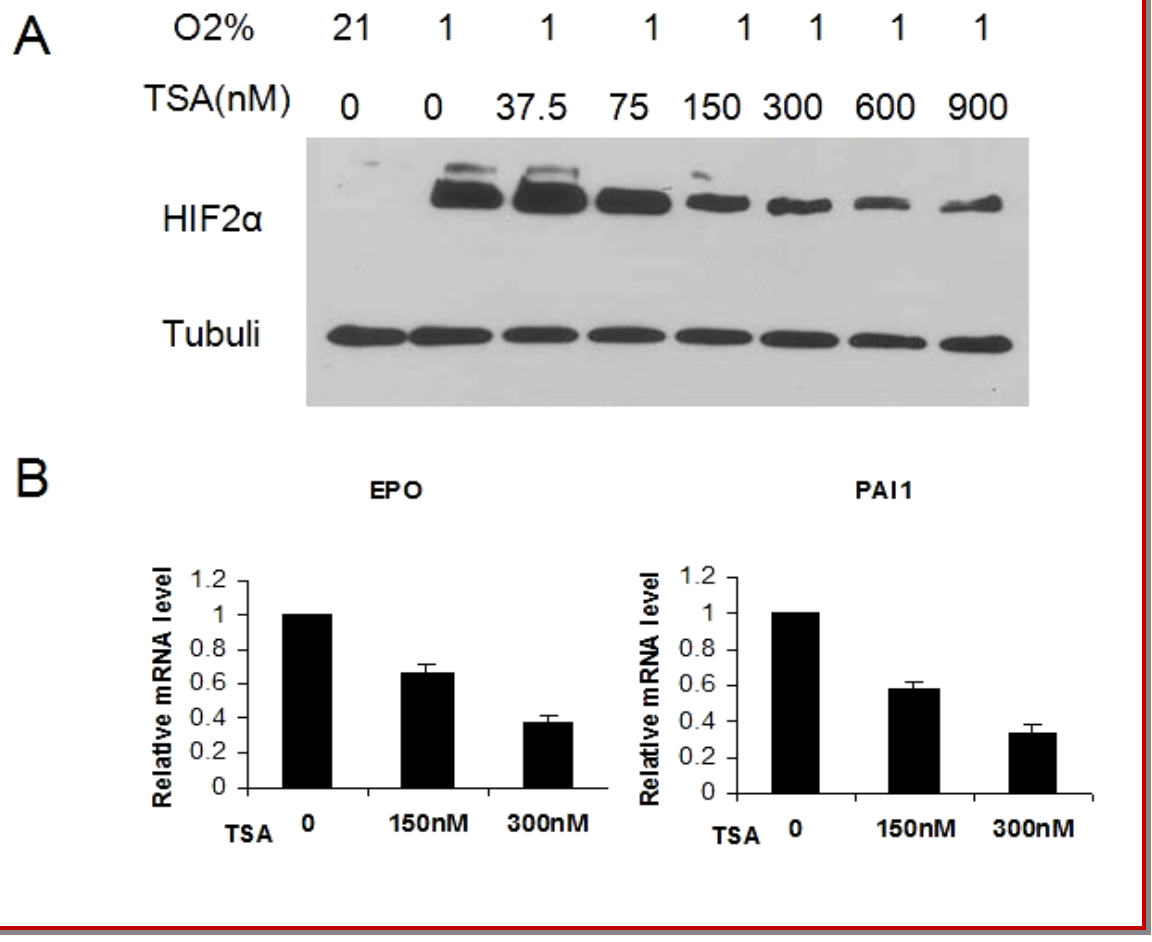
Figure 1: Effect of TSA on protein and mRNA expression of HIF-2 α (A) MG-63 cells were exposed to 1% oxygen in the presence of TSA at different concentrations for 8 hours, and cell extracts were subjected to SDS- PAGE followed by immunoblotting. (B) VHL deficient (-/-) 786-0 cells were treated with TSA at different concentrations for 16 hours in normoxia, total RNA was isolated and qRT-PCR was performed to detect the relative mRNA expression levels of HIF-2 α, HIF-2 α specific target genes EPO and